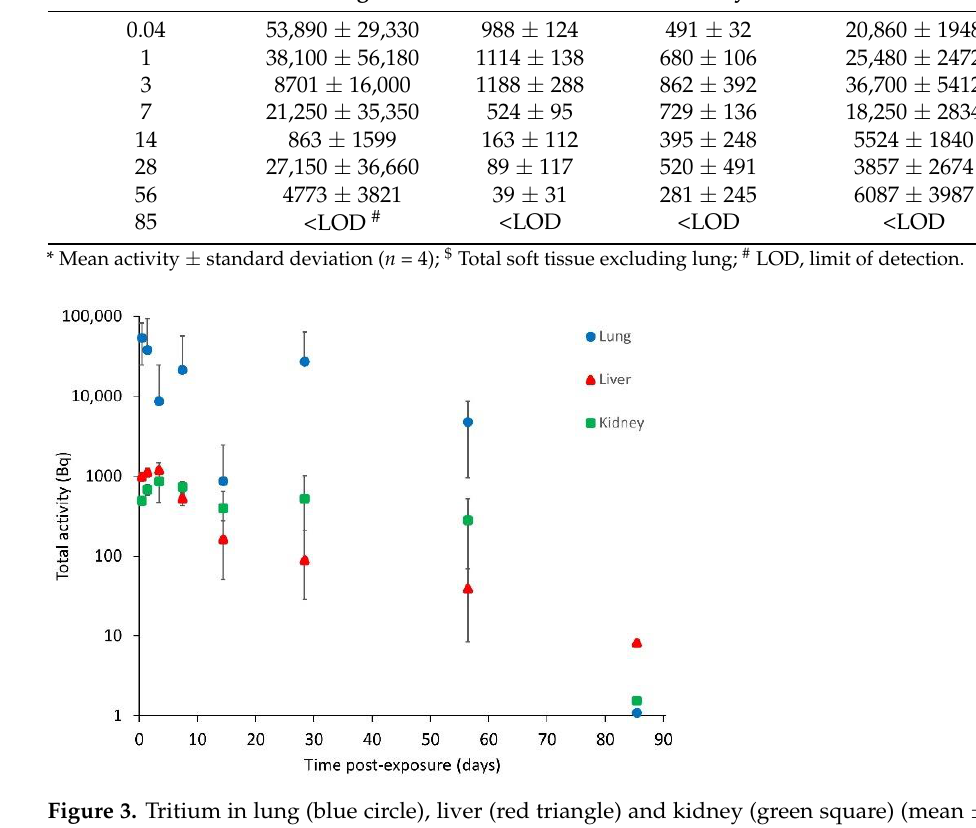
Table 2. Tritium in lung, liver, kidney and total soft tissue. Post-Exposure Time (d)